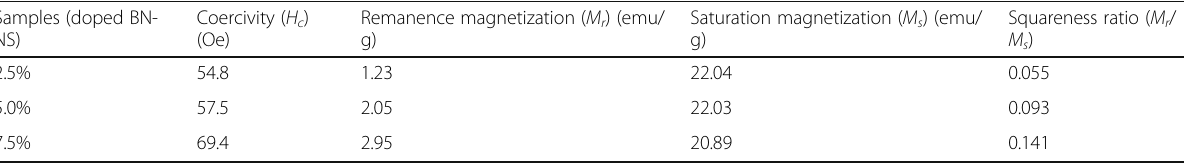
Table 1 Magnetic properties of various Co-doped BN-NS samples Samples (doped BN-